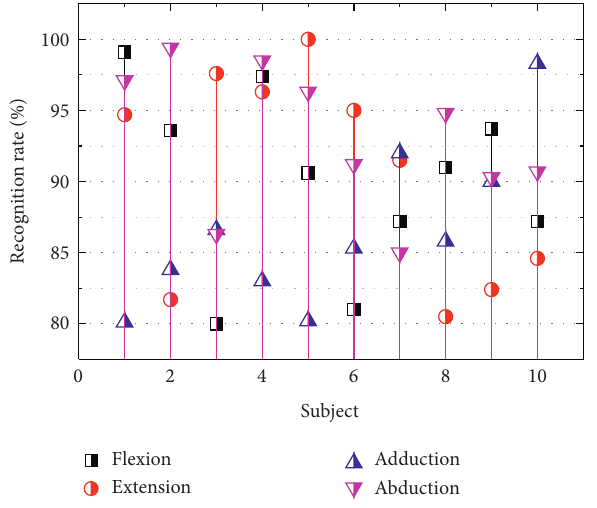
Figure 9: Classification results.